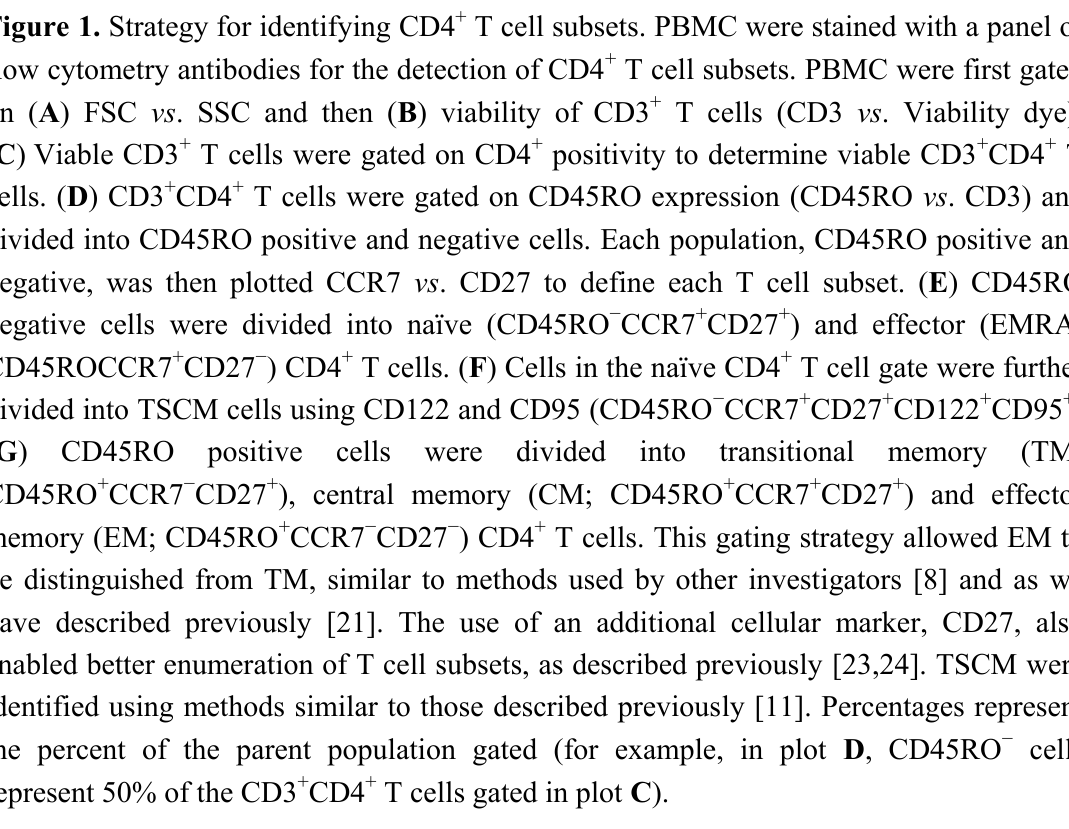
Figure 1. Strategy for identifying CD4 + T cell subsets. PBMC were stained with a panel of flow cytometry antibodies for the detection of CD4 + T cell subsets. PBMC were first gated on ( A ) FSC vs . SSC and then ( B ) viability of CD3 + T cells (CD3 vs . Viability dye). ( C ) Viable CD3 + T cells were gated on CD4 + positivity to determine viable CD3 + CD4 + T cells. ( D ) CD3 + CD4 + T cells were gated on CD45RO expression (CD45RO vs . CD3)